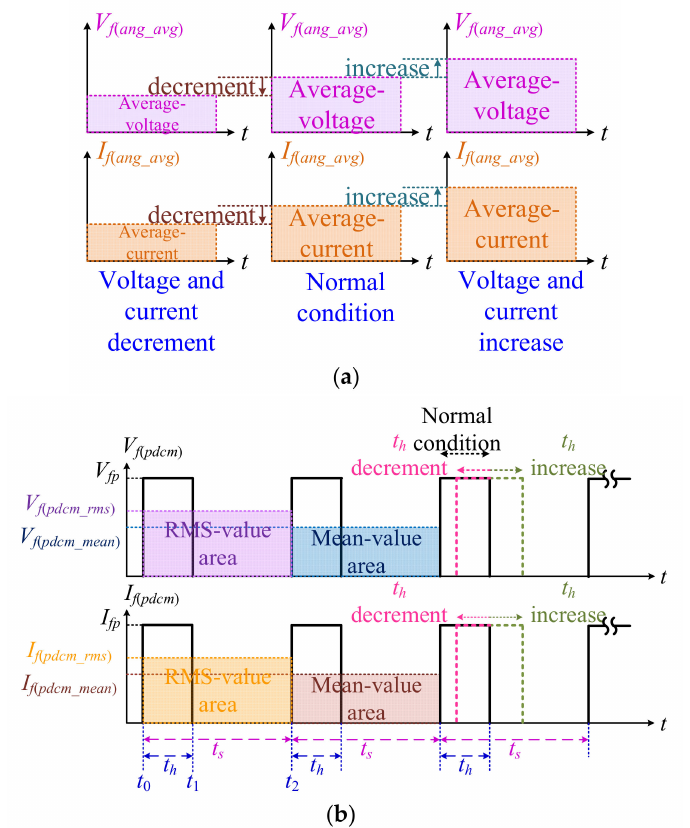
Figure 2. Di ff erent modulation methods. ( a ) Average-current modulation. ( b ) PDCM